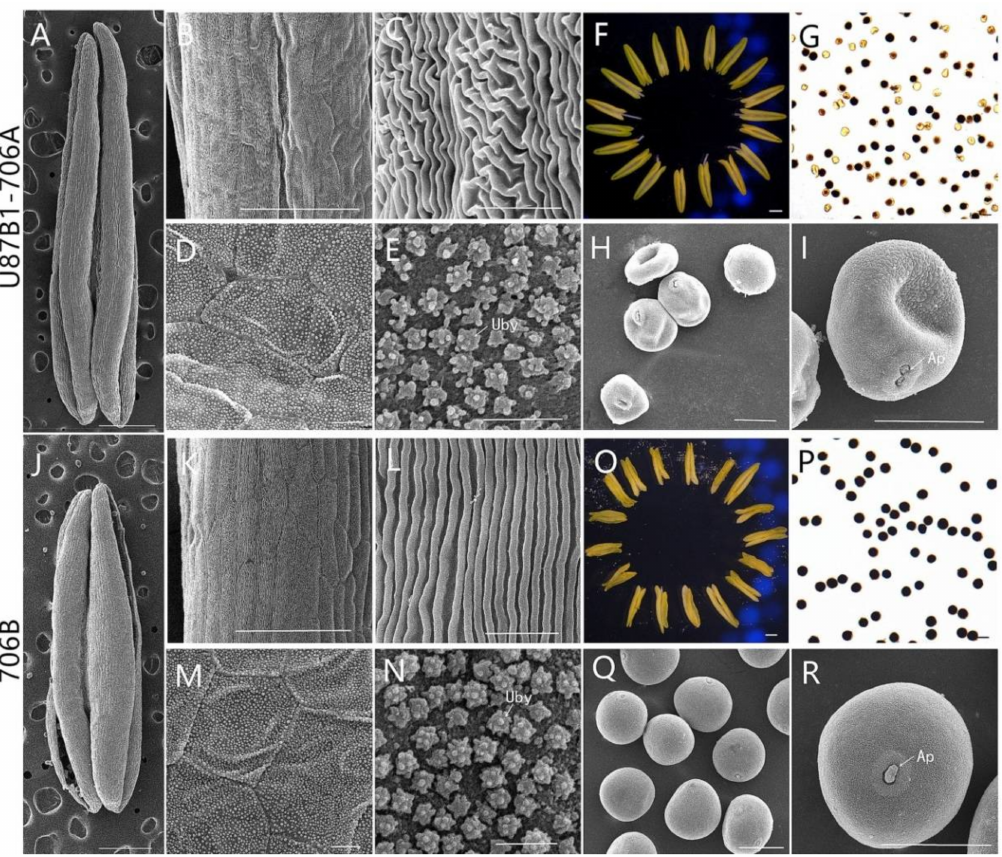
Figure 2. Comparison of scanning electron micrograph observations, I 2 -KI staining, and anther morphology in U87B1-706A ( A – I ) and 706B ( J – R ) at the trinucleate (Tn) stage. ( A , F , J , O ): anthers; ( B , C , K , L ): outer epidermal cells; ( D , E , M , N ): inner epidermal cells; ( G , P ): microspores by I 2 -KI